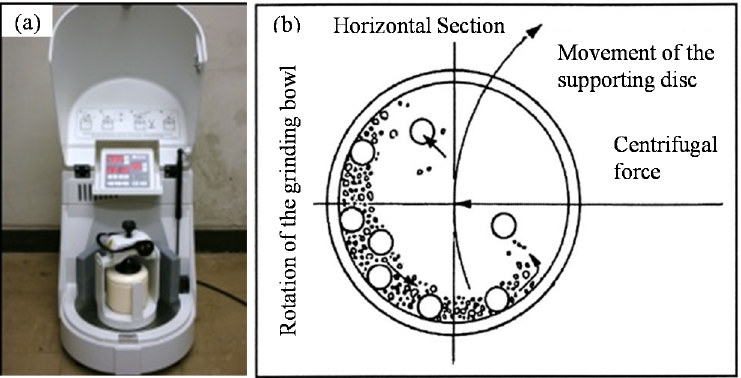
Figure 3. Planetary ball mill and ball motion. ( a ) Planetary ball mill; ( b ) Schematic depicting the ball motion inside the ball